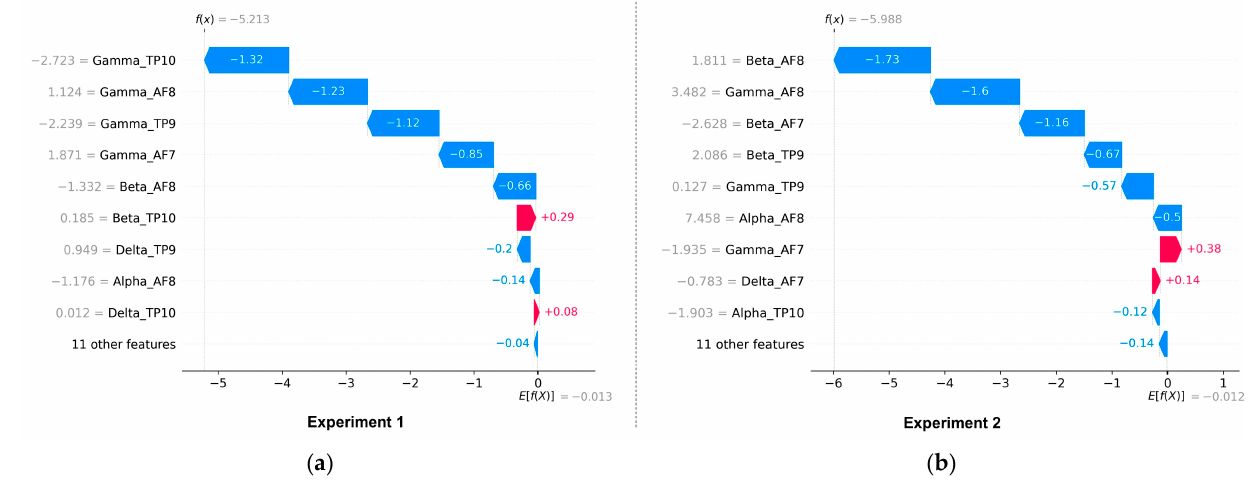
Figure 12. ( a , b ) Local contribution of various EEG features in the proposed model (CNN-BiLSTM- CRF) for Experiment 1 and Experiment 2, respectively.